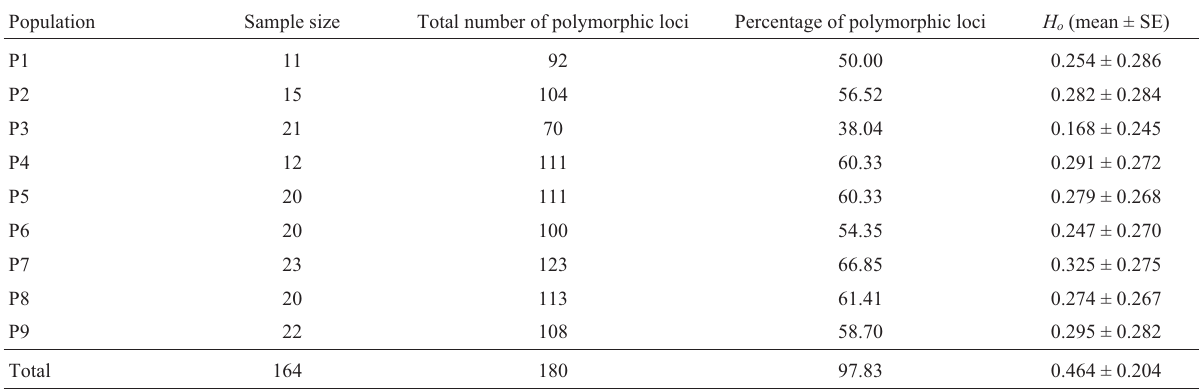
Table 2 - Genetic variation between populations of Rhodiola crenulata based on 184 ISSR markers.